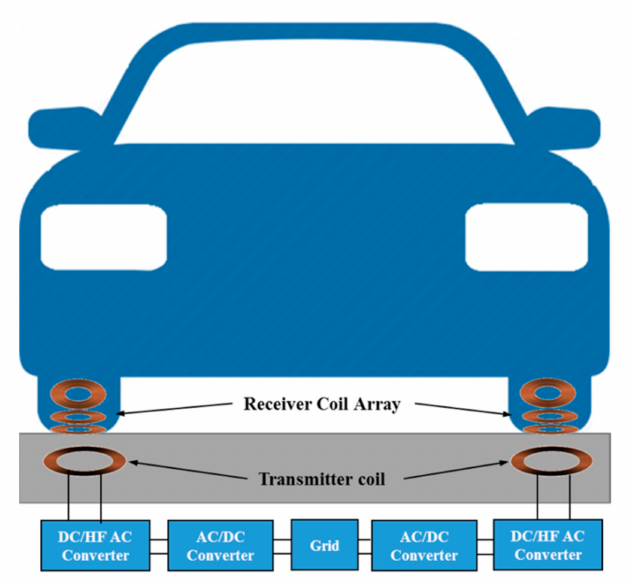
Figure 3. Basic schematic diagram of the in-wheel WPT